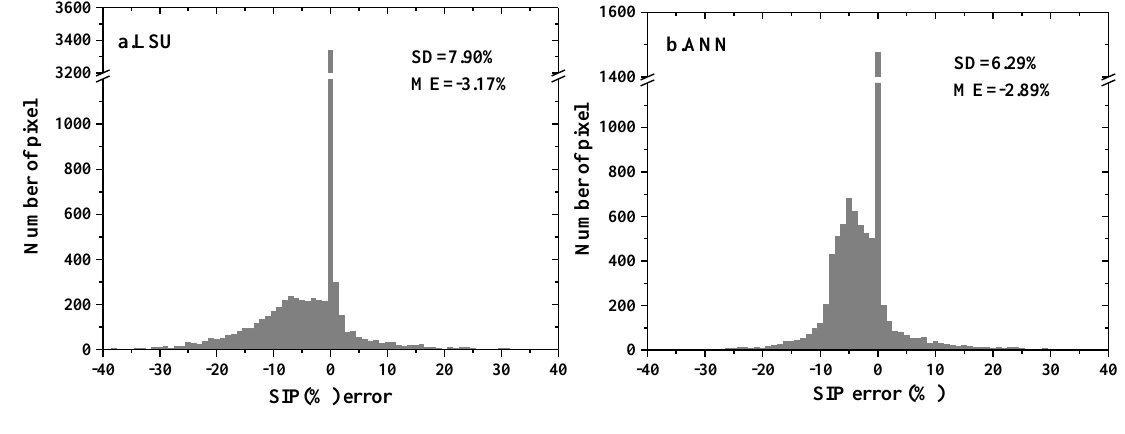
Figure 12. Cont. Figure 12. Cont.